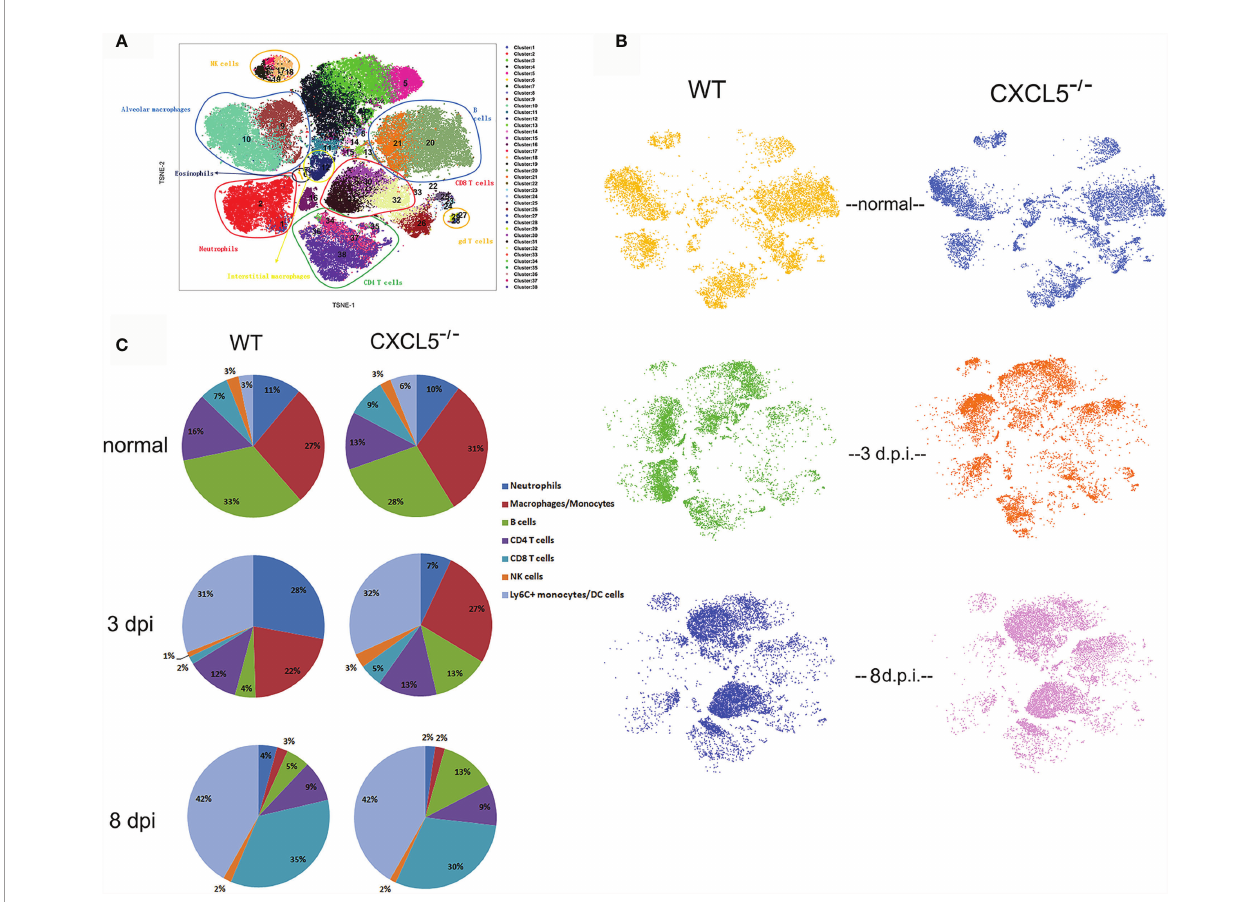
FIGURE 4 | CyTOF analysis and comparison of leukocyte compositions in WT and CXCL5 -/- mouse lungs before and after in fl uenza infection. (A) tSNE analysis of CD45+ single-cell data from the mouse lung tissues. The cells were plotted and color-coded according to 38 clusters using the X-shift clustering algorithm. The detailed characterization of each cluster is shown in Supplemental Figure 2 . The different cell subsets were divided by their surface marker expression patterns in normal mouse lungs as described previously (18). (B) tSNE analysis of the leukocyte compositions of lung tissues derived from WT and CXCL5 -/- mice (n=1) before and after (at 3 d.p.i. and 8 d.p.i.) in fl uenza infection. (C) The cell frequencies of the indicated major leukocyte subsets are illustrated for the lungs of WT and CXCL5 -/- mice